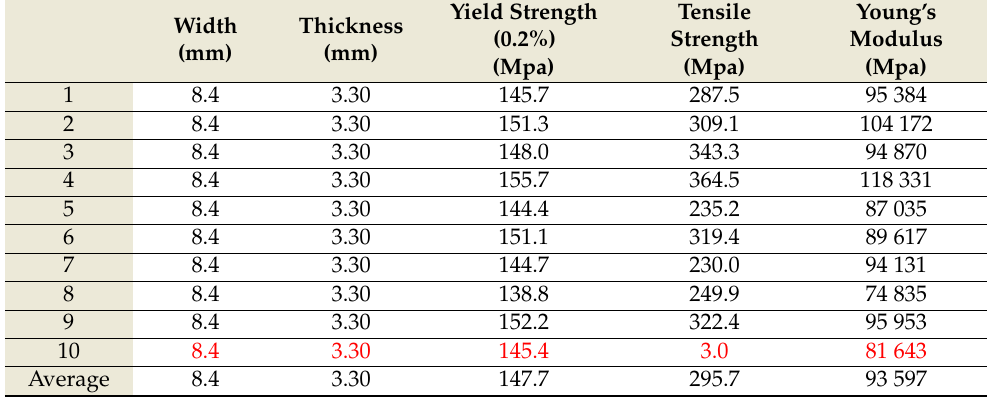
Table 4. Data collected from static tensile strength for samples with lamination angle 90 (cid:3042) and en- velope